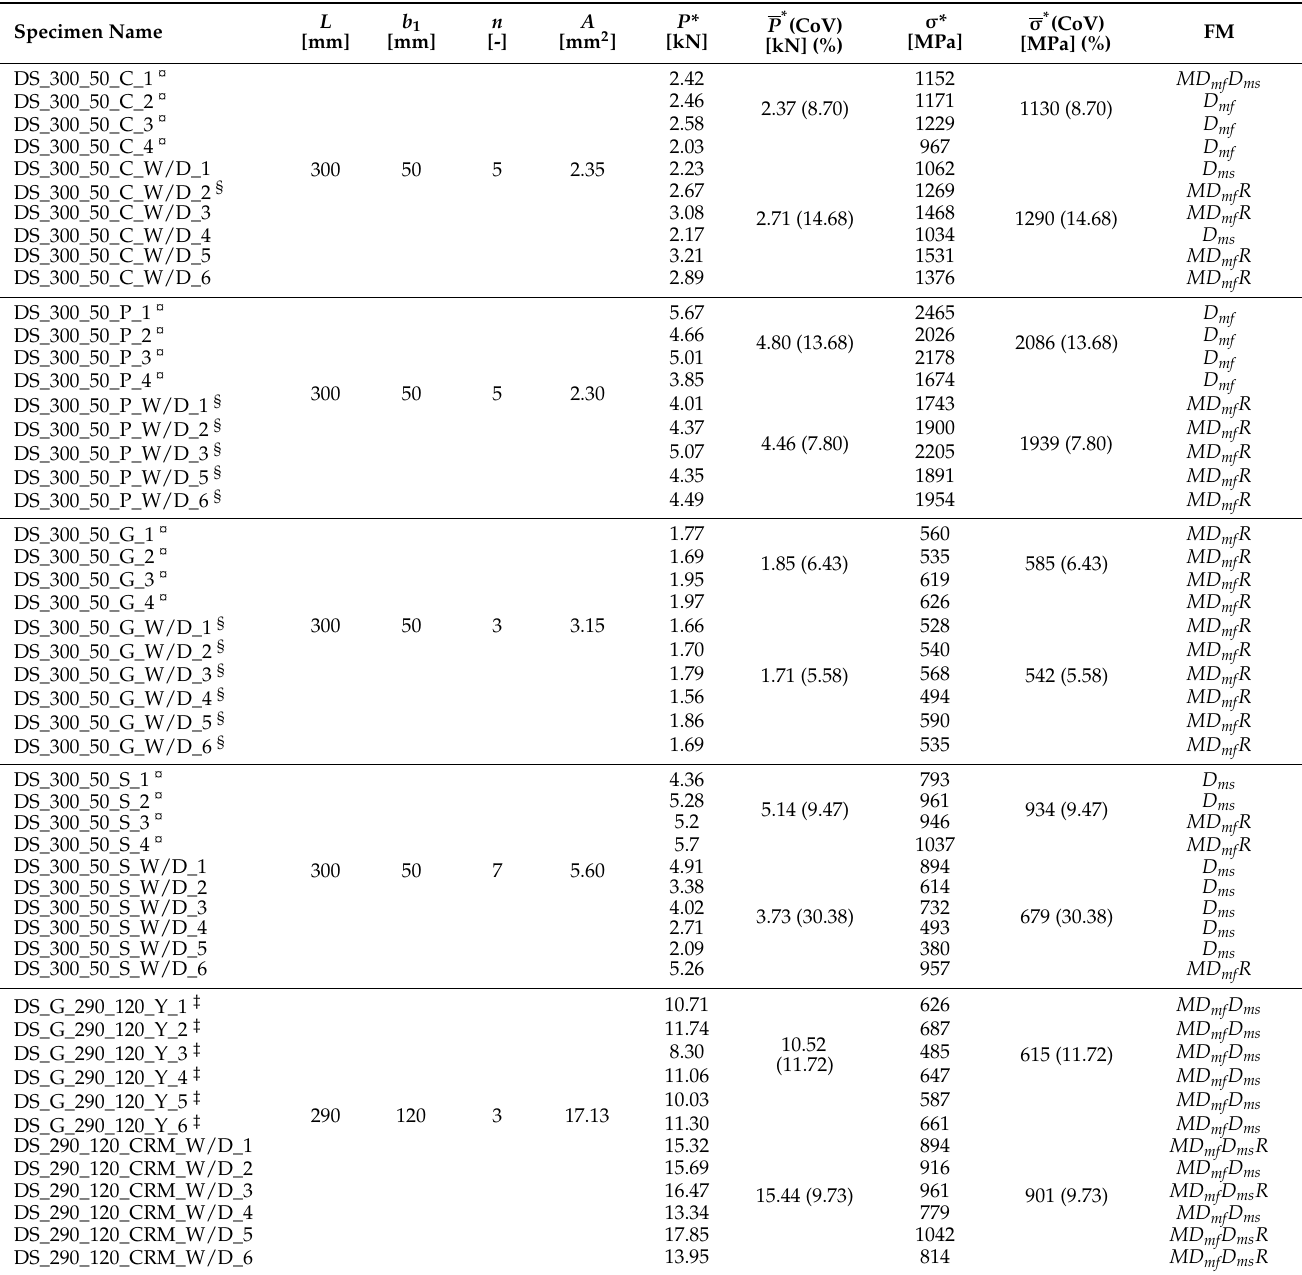
Table 2. Results of direct shear single-lap